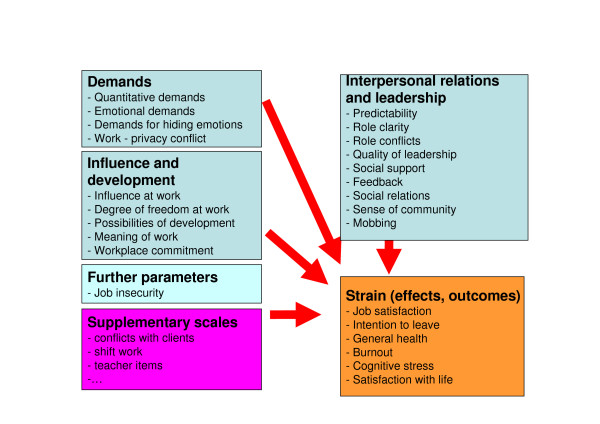
Content of the German standard COPSOQ.